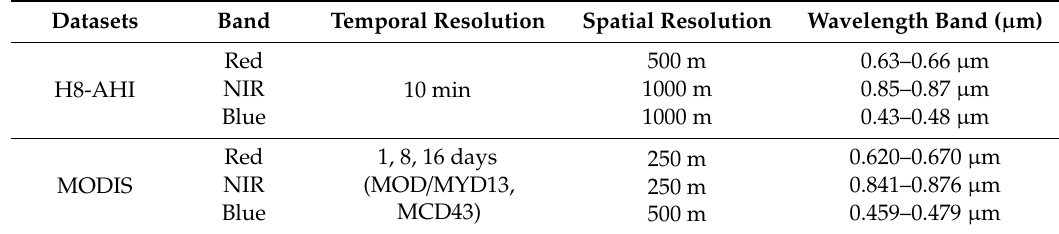
Table 2. The spectral, spatial, and temporal resolutions of AHI and MODIS (Moderate Resolution Imaging Spectroradiometer) data used in this study.